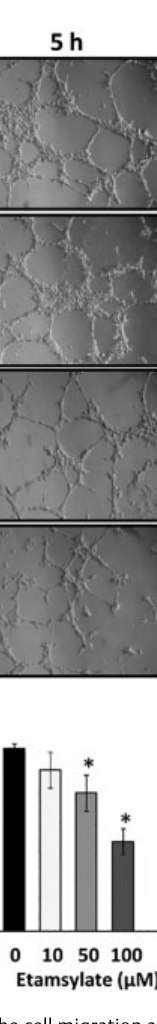
Fig. 2 Effect of etamsylate on angiogenesis in HUVECs. ( A ) Wound-healing assay. In the representative images shown, the cell migration after etamsylate administration is observed. In the lower part, the percentage of wound healing (migration) in time is represented. The mean with SD is shown. Values are normalized with control. Statistical signi fi cance was studied using Student ’ s t -test. (cid:3) p < 0.05. ( B ) Tubulogenesis assay. Representative images are shown, demonstrating a lower amount of tubes in the treated cells compared with untreated cells. The different tube densities are shown in a representative experiment. The mean with SD is shown. Values are normalized with control. Statistical signi fi cance was studied using Student ’ s t -test. (cid:3) p < 0.5. HUVECs, human umbilical vein endothelial